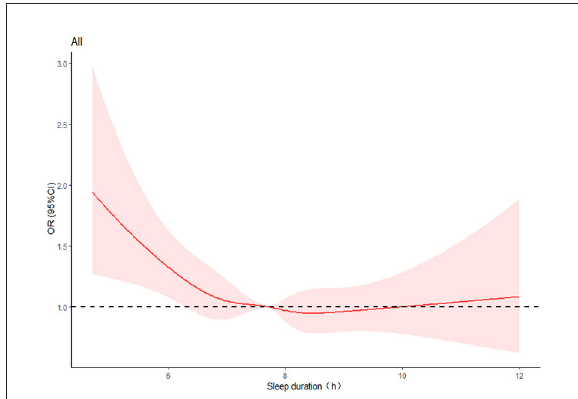
FIGURE2 Restricted cubic spline plots of the relationship between nocturnal sleep duration and hyperuricemia. The curve was computed using restricted cubic spline (RCS) function that took into account variables including gender, age, marital status, education level, annual household income, work intensity, sedentary time, position levels, participating in physical exercise, smoking, drinking, having mood symptoms, irregular meal habits, midnight snacks, using hypnotics, nap duration, obesity, DM, hypertension, and dyslipidemia. The red area represents the 95% confidence interval for the odds ratio. The dotted line shows the level at which the OR value is equal to 1.